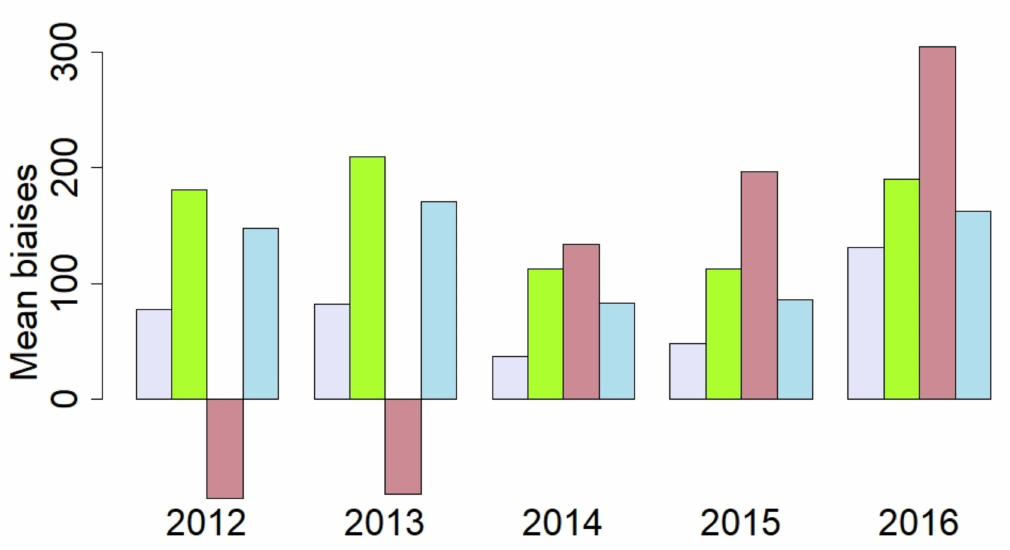
Figure 10. Performance indicators of net primary productivity model outputs for years 2012 to 2016 (comparisons with field estimates), when using PFT traits , field mean traits , computed traits or site traits : R-squared, root mean squared errors (RMSE, g C/sq. m/yr) and mean biases (g C/sq.